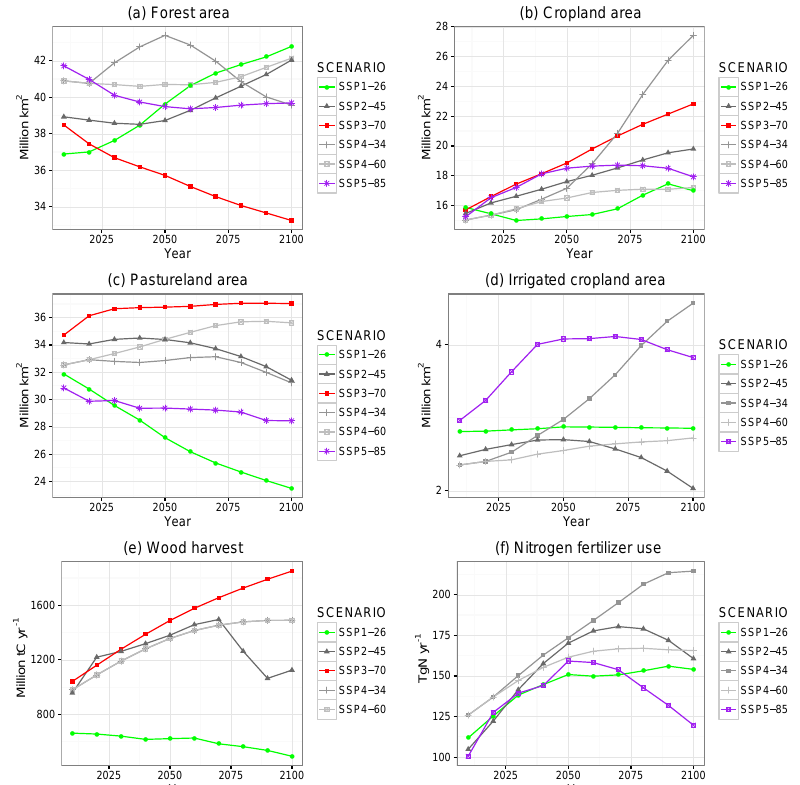
Figure 6. Global time series of land cover (a) , land use (b, c, e) , and land management (d, f) for the future simulations. Lines indicate SSP-RCP scenarios chosen for ScenarioMIP, with colored lines representing scenarios with specific LUMIP experiments. Data is provided by the IAM community. Data will be harmonized to ensure consistency between the end of the historical period and the beginning of the projection period for each of the scenarios. Note that not all IAMs predict all the LUH2 land management quantities (e.g., wood harvest is missing for SSP5-8.5). The missing land management variables will be generated during the harmonization process in a manner that is consistent with the underlying